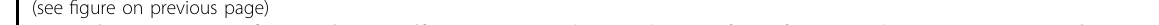
Fig. 3 Phase separation of IRS-1 relies on self-association. a Schematic diagram of IDR of mIRS-1 and its truncation mutants. b FLAG-tagged mIRS-1 mutant constructs as shown in ( a ) were co-transfected with GFP-mIRS-1 IDR (301 – 1233) into 293 T cells for immunoprecipitation analysis. c Schematic diagram of mIRS-1 and its deletion mutants. d FLAG-tagged and GFP-tagged mIRS-1 or mIRS-1 Δ SAR mutants were co-transfected into 293 T cells for immunoprecipitation analysis. Data in the bar graphs represent the means ± SEM values of the ratios of densities for three independent experiments. *** p < 0.001. e FLAG-tagged mIRS-1 mutant constructs were co-transfected with GFP-mIRS-1 301 – 600 into 293 T cells for immunoprecipitation analysis. f Representative confocal images of GFP-tagged mIRS-1, mIRS-1 Δ SAR mutant, and mIRS-1-TDP-43 mutant in C2C12 cells. Quanti fi cation results of GFP-mIRS-1 and mutant puncta are shown as violin plots ( n = 80). **** p < 0.0001. ns: not signi fi cant. g Confocal images and quanti fi cation of GFP-mIRS-1-TDP-43 mutant fl uorescence recovery after photobleaching. Scale bar, 1 µm. h Time-lapse imaging showing fusion of two GFP-mIRS-1-TDP-43 droplets in cells. Scale bar, 1 µm. i Immunoblot analysis of the indicated proteins in C2C12-IRS-1 KO cell lines stably expressing GFP-mIRS-1 (mIRS-1 WT, mIRS-1 Δ SAR, mIRS-1 Δ 600 – 800, mIRS-1 Δ 800 – 1000, and mIRS-1 Δ 1001 – 1233). j Confocal images of GFP-tagged mIRS-1 wildtype and mutants in C2C12 cell lines as indicated in ( i ). Scale bar, 10 µm. Quanti fi cation results of GFP-mIRS-1 or mutant puncta are shown as violin plots. **** p < 0.0001. ns not signi fi cant. k DIC images of FLAG-mIRS-1 and mIRS-1 Δ SAR LLPS. The proteins (1 μ M) were incubated with phase separation buffer at room temperature for 20 min. Scale bar, 20